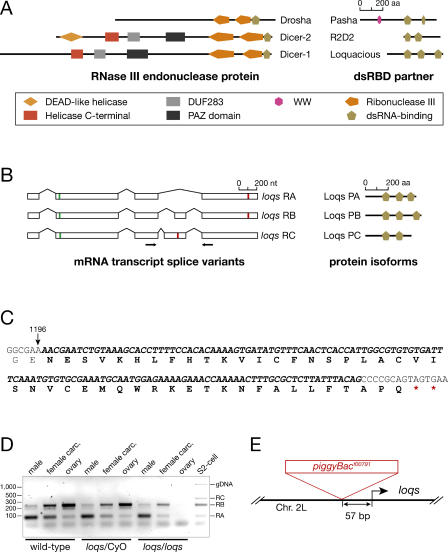
Loqs, a dsRBD Partner Protein for Drosophila Dcr-1(A) Each of the three D.
melanogaster RNase III endonucleases pairs with a different dsRBD protein, which assists in its function in RNA silencing.(B) Differential splicing creates three loqs mRNA variants, loqs RA, RB, and RC. loqs RA and RB are reported in FlyBase. The RC splice variant is reported here. Arrows mark the position of the PCR primers used in (D); green lines, start codons; red lines, stop codons. The resulting protein isoforms are diagrammed to the right.(C) Use of an alternative splice acceptor site extends the 5′ end of exon 4. The mRNA sequence surrounding the new exon–exon junction is shown, with the loqs RC-specific sequence in bold; the arrow marks the position of the last nucleotide of exon 3 relative to the putative transcription start site. When translated into protein, the exon 4 extension inserts 43 new amino acids (indicated below the mRNA sequence) and shifts the Loqs PC reading frame, truncating the protein.(D) RT-PCR analysis of loqs mRNA species in males, female carcasses remaining after ovary dissection, dissected ovaries, and S2 cells. Males express more loqs RA than loqs RB, female somatic tissue expresses both loqs RA and loqs RB, while ovaries express predominantly loqs RB. loqs RC was observed only in S2 cells, together with loqs RA and loqs RB.(E) The piggyBac transposon insertion f00791 lies 57 bp upstream of the reported transcription start site for loqs.